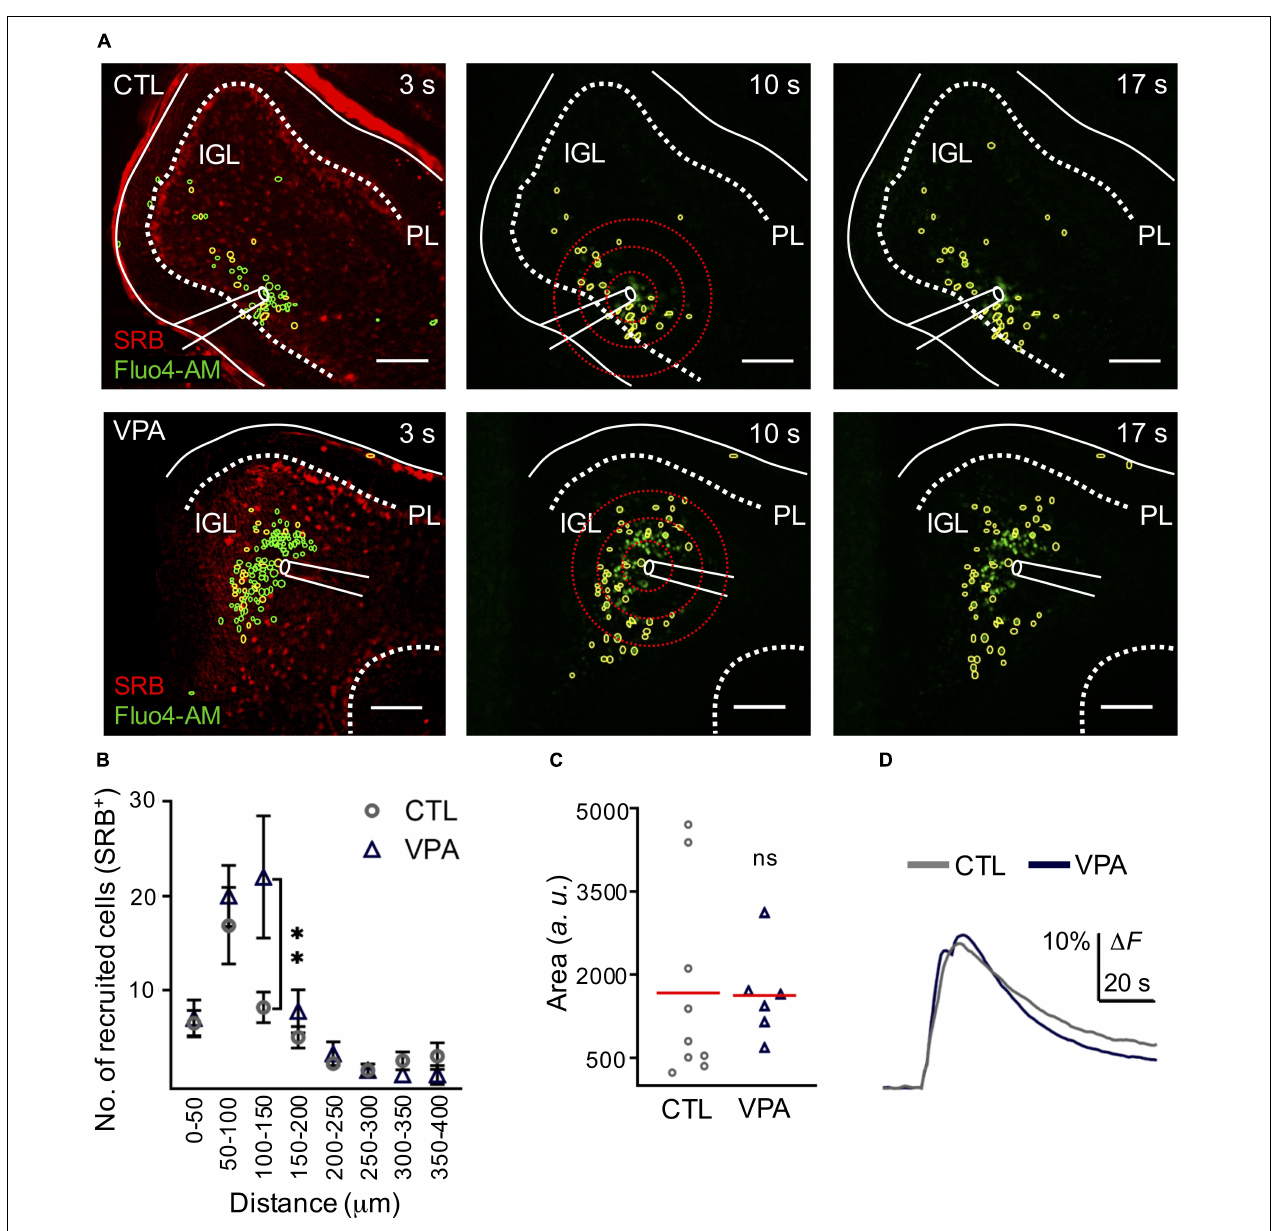
FIGURE 3 | Astrocyte recruitment is augmented within the calcium wave in the VPA model. (A) Representative CTL and VPA images of an evoked calcium wave (Fluo4-AM in green) in IGL; at three different times (3, 10, and 17 s). Regions of Interest (ROIs) showed a fraction of Fluo-4AM cells that incorporated SRB (yellow ROIs), the rest of the recruited cells (green ROIs). Scale bar 100 µ m. (B) Histogram of SRB + cell recruitment per distance (n CTL = 6, n VPA = 4, and N CTL = 3 and N VPA = 3). (C) The mean amplitude of the calcium transient was estimated from all SRB + recruited cells within the calcium wave in both CTL (Cells CTL = 299, n CTL = 9, N CTL = 4) and VPA (Cells VPA = 340, n VPA = 6, N VPA = 3) experimental groups. (D) Summary of the mean amplitude of the calcium transient obtained from all the recruited cells from CTL and VPA groups. IGL, internal granular layer; PL, Purkinje layer. Data analyzed by Shapiro–Wilk, and Student’s t -test, ** p < 0.05. Values are mean ±